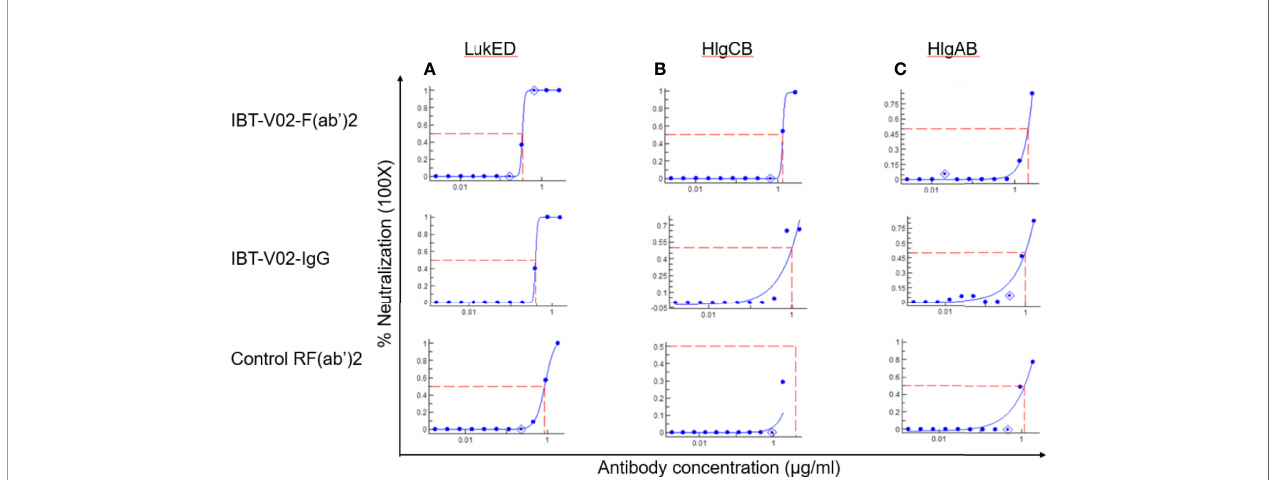
FIGURE 6 | Cross neutralization data against 90% effective concentration (EC 90 ) of (A) LukED, (B) HlgCB, and (C) HlgAB by IBT-V02-F(ab ’ )2, IBT-V02-IgG and negative control RF(ab ’ )2 tested in full curve and analyzed by a curve fi t in XLFit (IDBS,